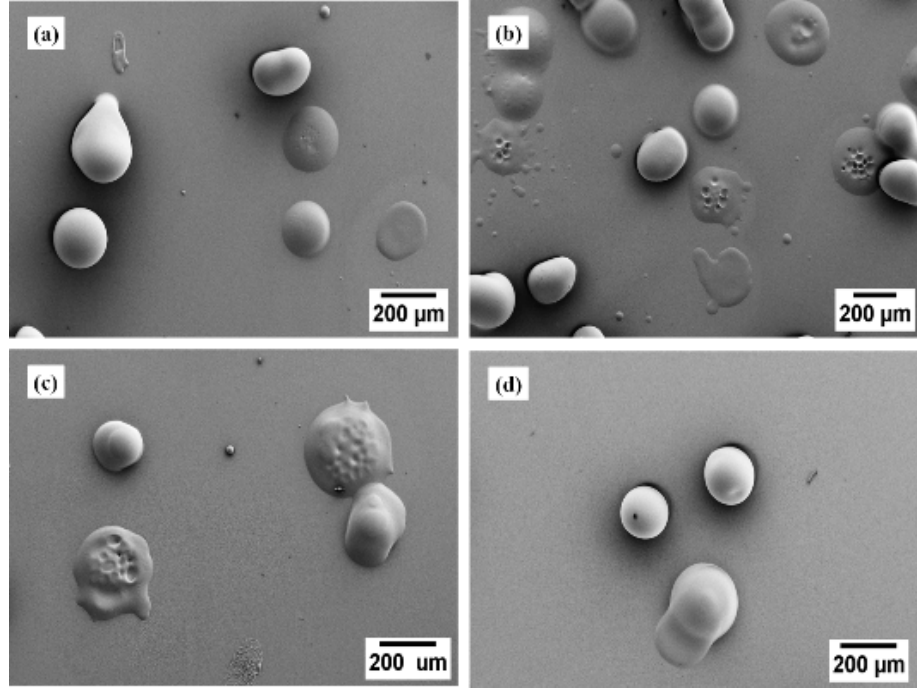
Figure 11. Typical single splats deposited on glass substrates ( a ) At 20 cm stand-off distance. ( b ) At 25 cm stand-off distance. ( c ) At 30 cm stand-off distance and ( d ) At 35 cm stand-off distance.